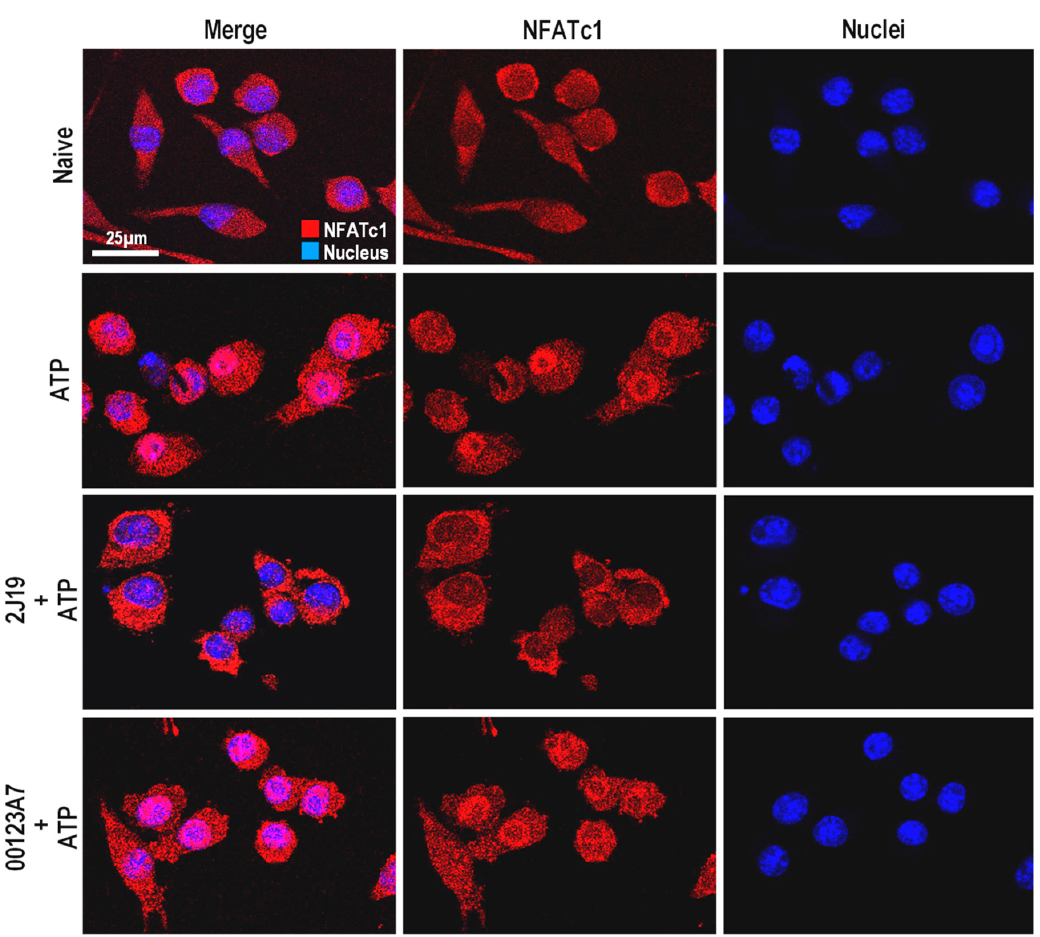
Figure 4. Modulation of NFATc1 nuclear translocation by 00123A7 and 2J19 GIB fractions. N9 microglial cells were pre-treated with 2J19 or 00123A7 GIB fractions for 6 h before ATP (3mM) stimulation for 60 min. Confocal immunofluorescence images of NFATc1 (red) and nuclei (blue) stained with DAPI. Each capture is representative of, at least, three independent biological replicates.